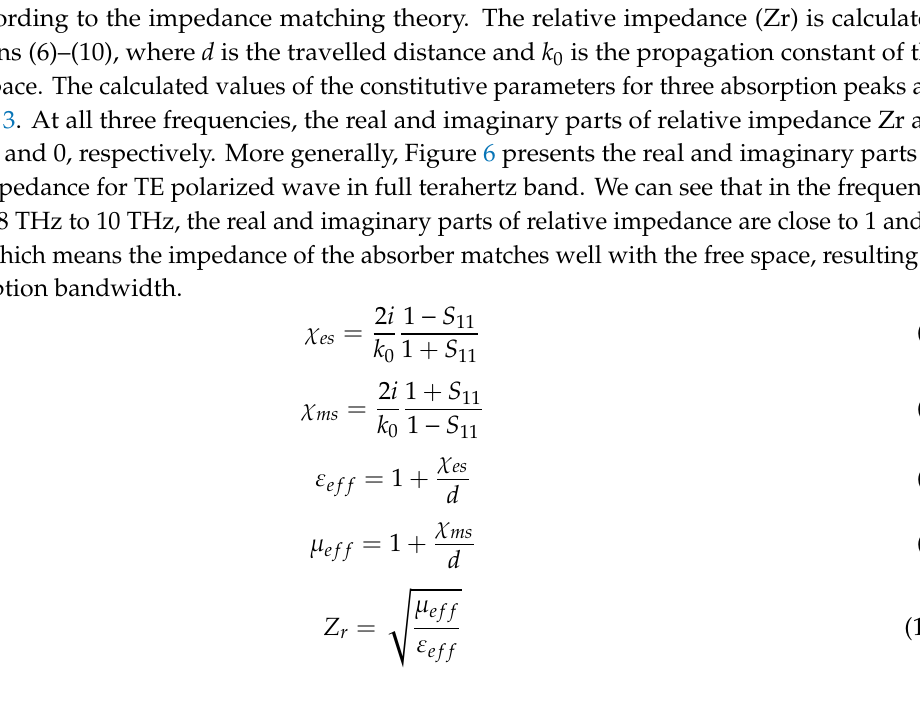
Table 3. Calculations of relative impedance of the proposed structure at peak